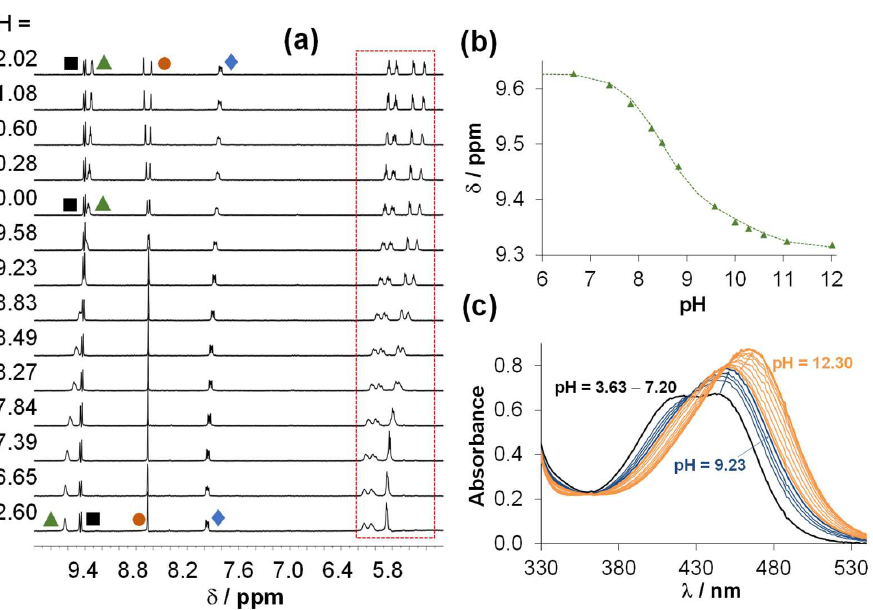
Figure 8. ( a ) Downfield region of the 1 H NMR spectra recorded for the RuCym complex of HQNO 2 -L-Pro in the pH range 2–12 in 10% ( v / v ) D 2 O/H 2 O and ( b ) the chemical shift of CH(2) protons plotted against the pH. Peak assignation is shown in Figure S9 and the framed peaks belong to the p -cymene aromatic CH protons. ( c ) UV-vis spectra of the same complex at different pH values. { c complex = 500 µ M ( 1 H NMR) and 50 µ M (UV-vis); I = 0.20 M KNO 3 ; l = 1 cm (UV-vis); t = 25.0 ◦